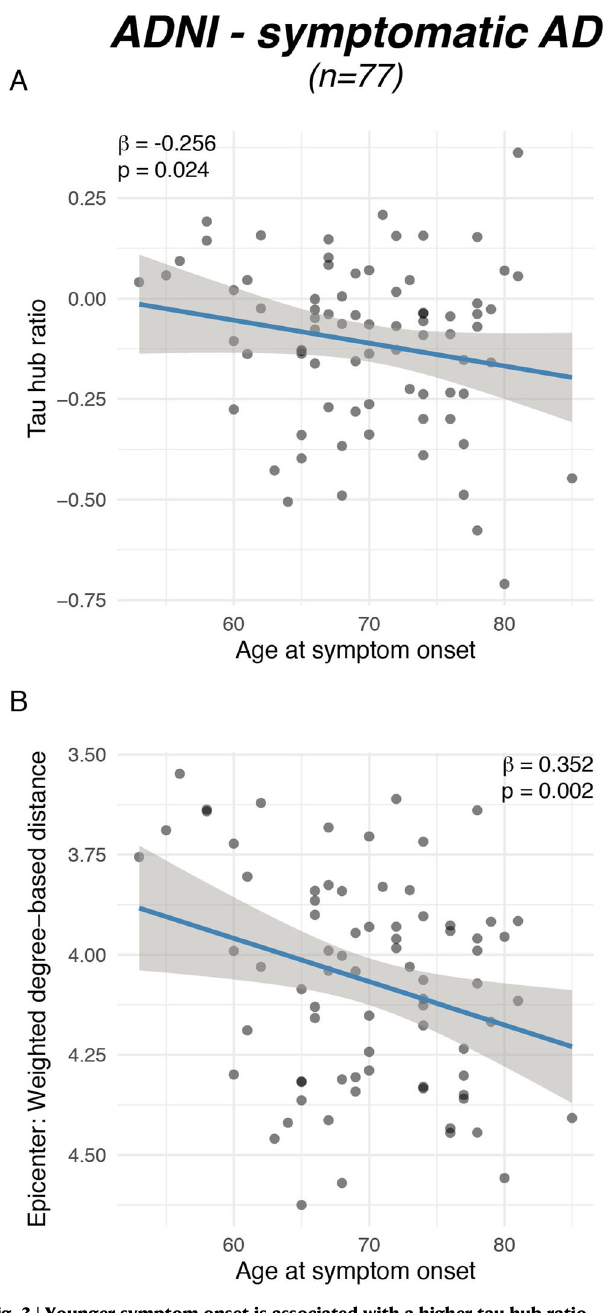
Fig. 3 | Younger symptom onset is associated with a higher tau hub ratio. Scatterplotsillustratingtheassociationbetween( A )actualageofonsetandthetau hubratiofor n =77symptomaticADsubjectsoftheADNIsampleaswellasbetween ( B ) age at symptom onset and global connectivity-based distance of the tau epi- centers. β -values re fl ect standardized regression weights. All β -and two-sided p values were derived from linear regression controlling for sex, education and diagnosis andthe time differencebetween ageofsymptom onset and the fi rst tau- PET scan. Linear model fi ts (i.e., least squares line) are indicated together with 95% con fi dence intervals. Source data are provided as a Source Data fi